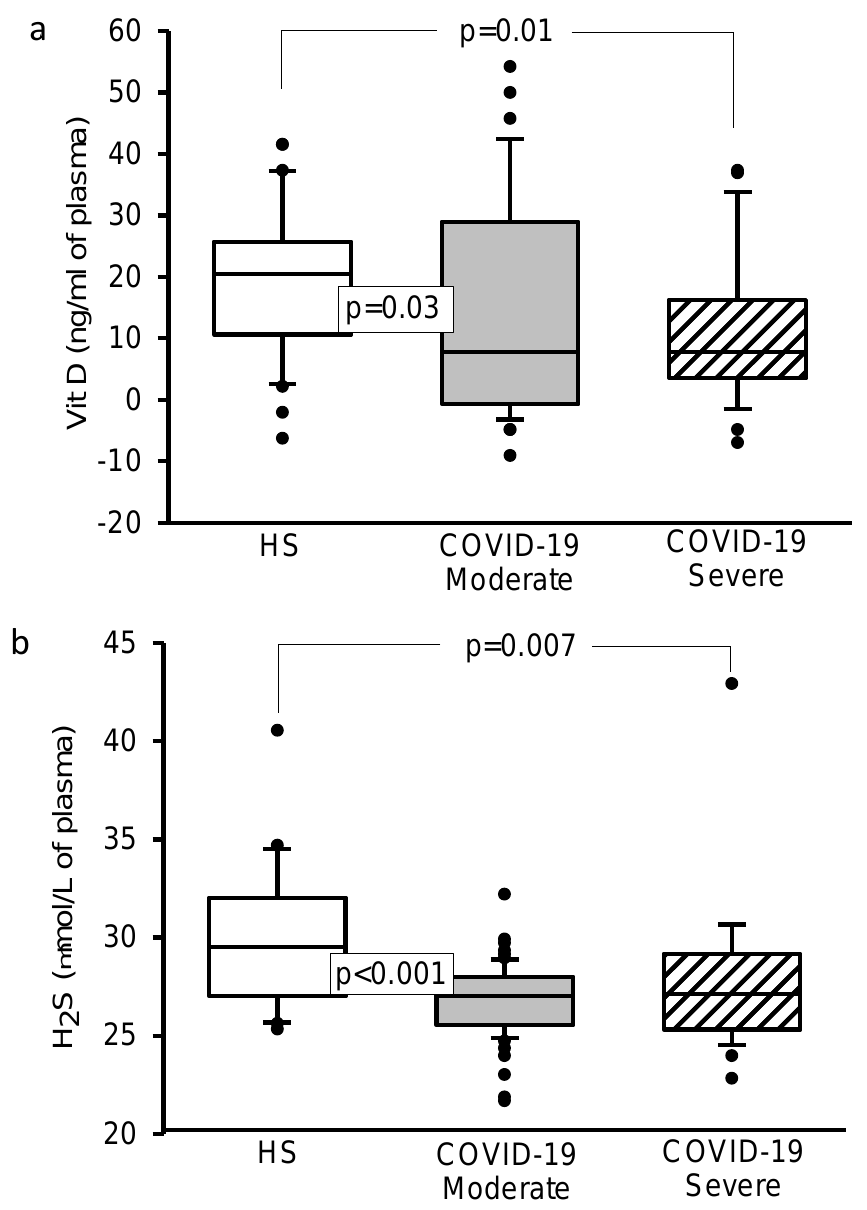
Figure 3. ( a ) Changes in the values of Vit D and ( b ) changes in the concentration of the H 2 S, there was a significant decrease in the moderate and severe COVID-19 patients in comparison with HS.